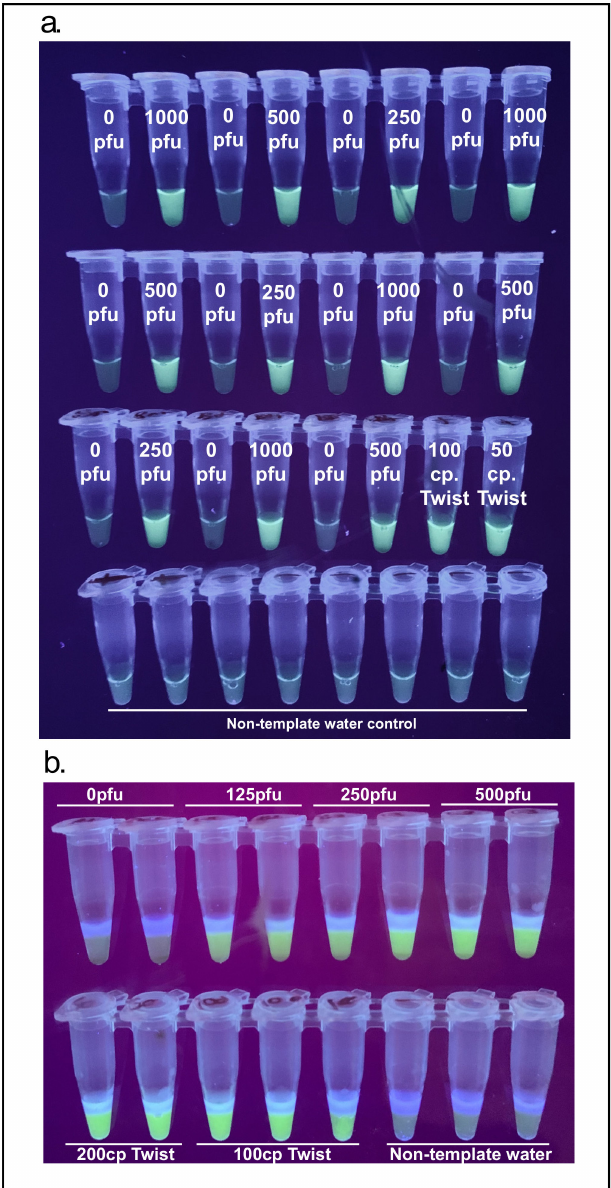
Figure 4. ( a ) Proteinase K lysis efficacy on nasal mid-turbinate (NMT) swabs spiked with 0, 1000, 500 and 250 pfus of severe acute respiratory syndrome coronavirus 2 (SARS-CoV-2), 100 copies of synthetic SARS-CoV-2 RNA, 50 copies of synthetic SARS-CoV-2 RNA and non-template water controls.; ( b ) TCEP/EDTA lysis efficacy on NMT swabs spiked with inactivated SARS-CoV-2. Bottom strip shows Twist Biosciences SARS-CoV-2 RNA and negative water